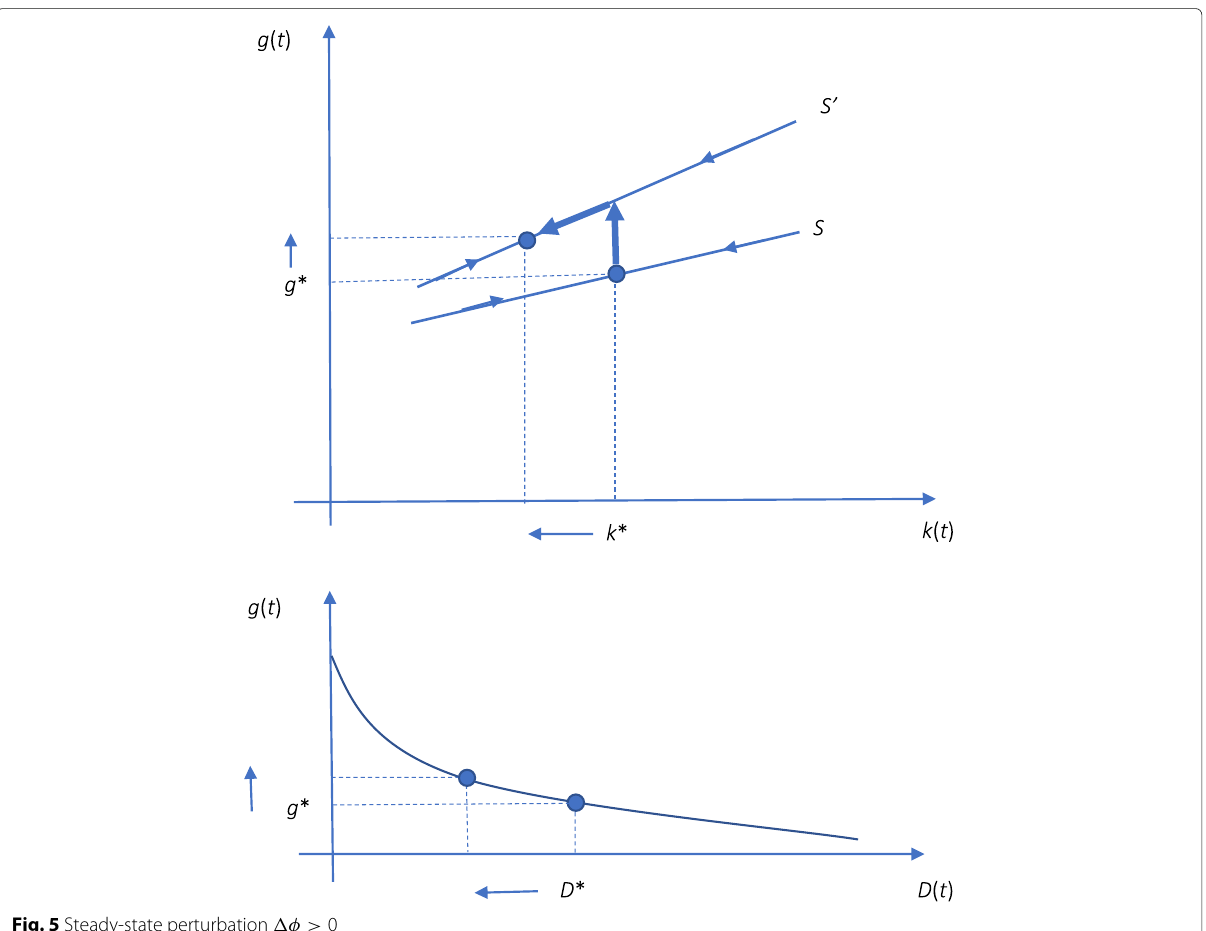
Fig. 5 Steady-state perturbation (cid:9)φ > 0